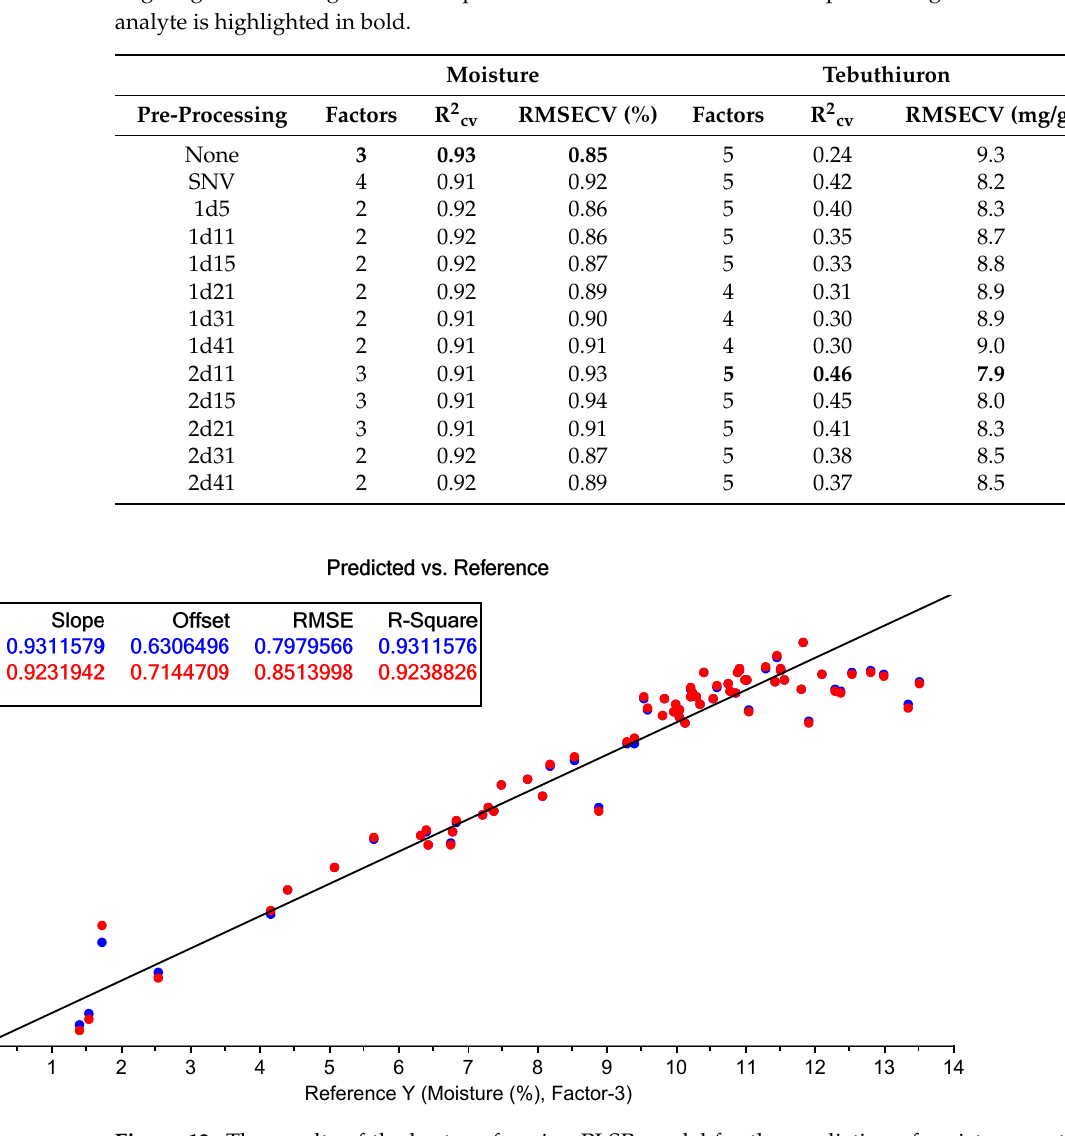
Figure 13. The results of the best-performing PLSR model for the prediction of moisture content using the benchtop NIR spectra collected from the Regain granules (using no pre-processing). The blue points show the model calibration, while the red points show the model cross-validation.